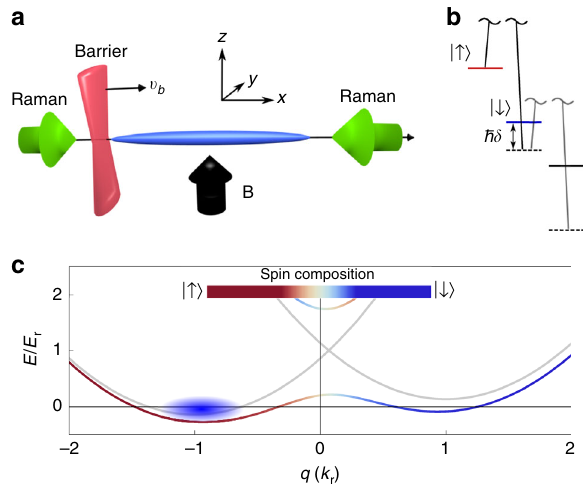
Fig. 2 Experimental setup. a Two counter-propagating Raman beams applied along x induce SO coupling along the elongated axis of the BEC. A repulsive, spin-independent optical barrier is initially positioned outside of the BEC and then swept along the x -axis at a constant velocity, v . b Two pseudospin states, m F = − 1 ( ≡ | ↑ 〉 ) and 0 ( ≡ | ↓ 〉 ), are Raman b coupled with coupling strength Ω and detuning δ , while the m F = + 1 state is effectively decoupled from the system. c The resulting SO-coupled double-well band dispersion for parameters ℏ Ω = 1.53 E r , ℏ δ = 0.27 E r . Colors of band represent the spin composition of the dressed states, where red (blue) represents the | ↑ 〉 (| ↓ 〉 ) spin state. The blue shaded oval in the left dispersion minimum represents the initial state and